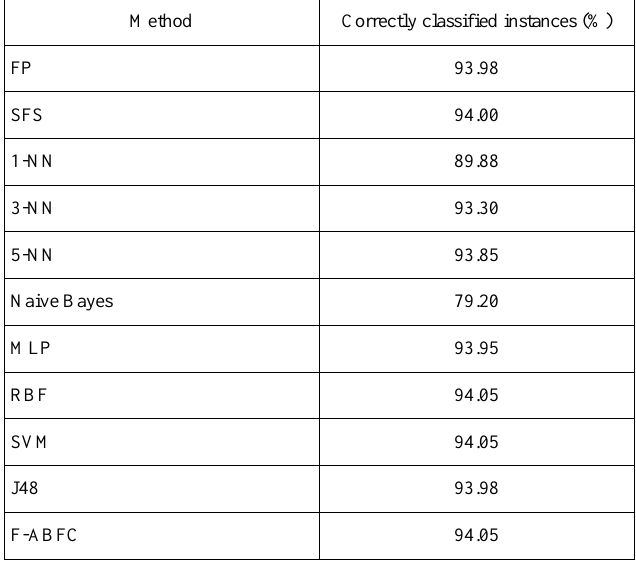
P REDICTIVE P ERFORMANCE OF THE M ETHODS IN TERMS OF THE N UMBER OF C ORRECTLY C LASSIFIED I NSTANCES (%)